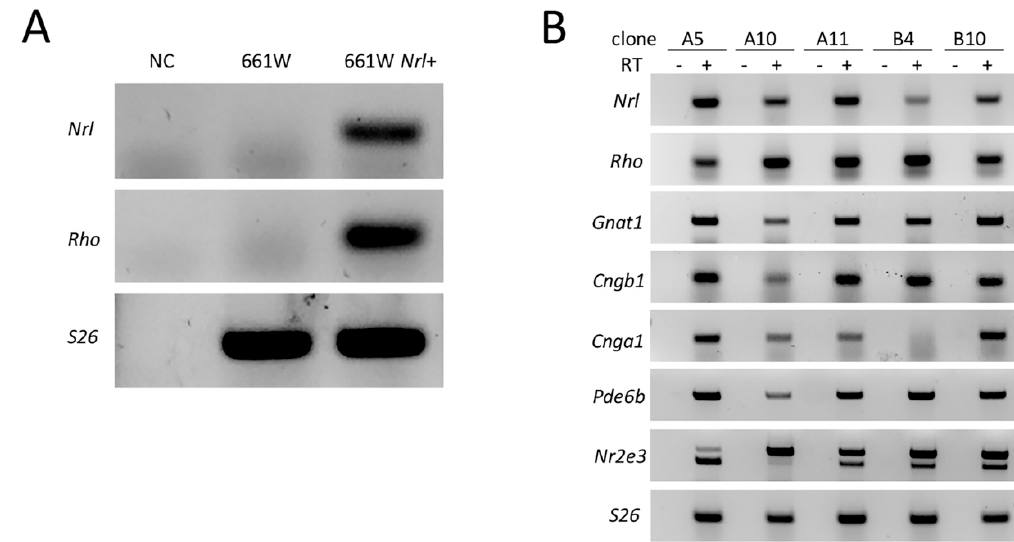
Figure 1. Generation and selection of Nrl -expressing 661W cells. ( A ) RT-PCR analysis of Nrl and Rho mRNA on 661W and 661W Nrl + cells (bulk of retroviral transduced cells). Ribosomal protein gene RPS26 ( S26) was analyzed as a reference gene. Expression of Nrl and Rho was confirmed in 661W transduced cells but not 661W cells. NC: negative control without cDNA (retrotranscription − ). ( B ) Five clones showed differential expression of rod-specific genes when analyzed by RT-PCR (RT - or +: retrotranscription − or +). S26 was analyzed as a reference gene. The primers for Nr2e3 also amplified a transcript variant with an intron inclusion reported in IMAGE:5357172. For Nr2e3 , we evaluated only the lower molecular weight band corresponding to the spliced mRNA.